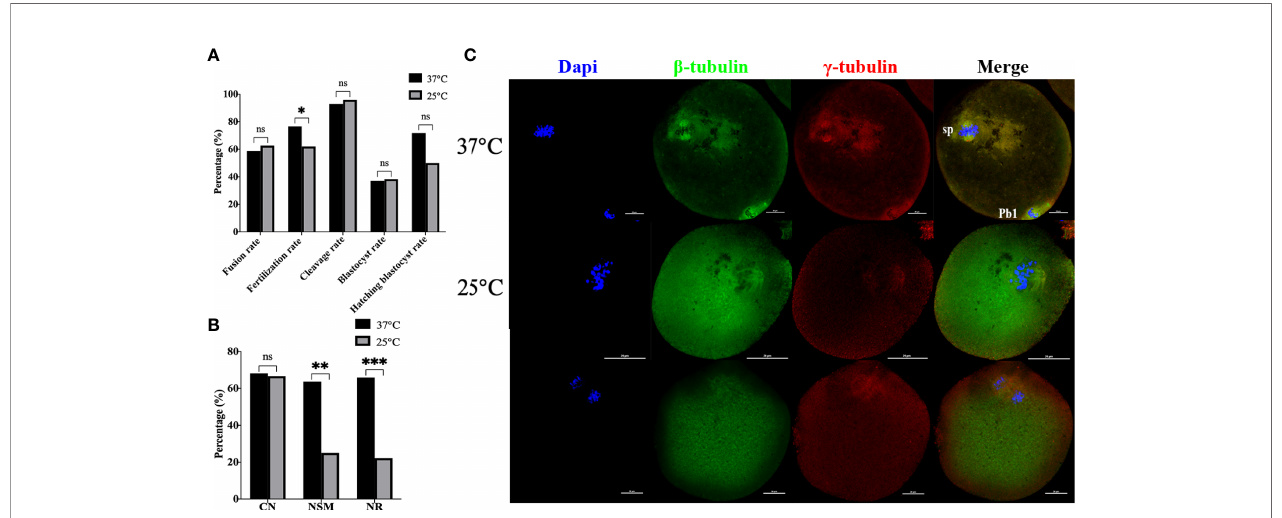
FIGURE 6 | Transient room temperature treatment after enucleation did not inhibit premature activation. (A) Transient room temperature treatment did not signi fi cantly affect the development potential of ST reconstructed embryos, but had an adverse effect on fertilization. ns P>0.05, *P<0.05. (B) Immuno fl uorescence staining results showed that transient room temperature treatment could lead to abnormal spindle function in ST reconstructed oocytes. **P<0.01, ***P<0.001. Representative images are shown in (C) . For 37°C the images are normal. The middle 25°C showed that after transient room temperature treatment, the chromosomes were disordered, irregularly localized at the equatorial plate, with abnormal spindle morphology and g -tubulin localization, while in the bottom 25°C images, the chromosomes separated in advance, the spindle microtubulin disappeared, and the g -tubulin aggregated towards the middle of the spindle. 37°C and 25°C respectively represent the 37°C treatment group and the 25°C treatment group. Data is expressed as a percentage (%). Scale bar, 20 m